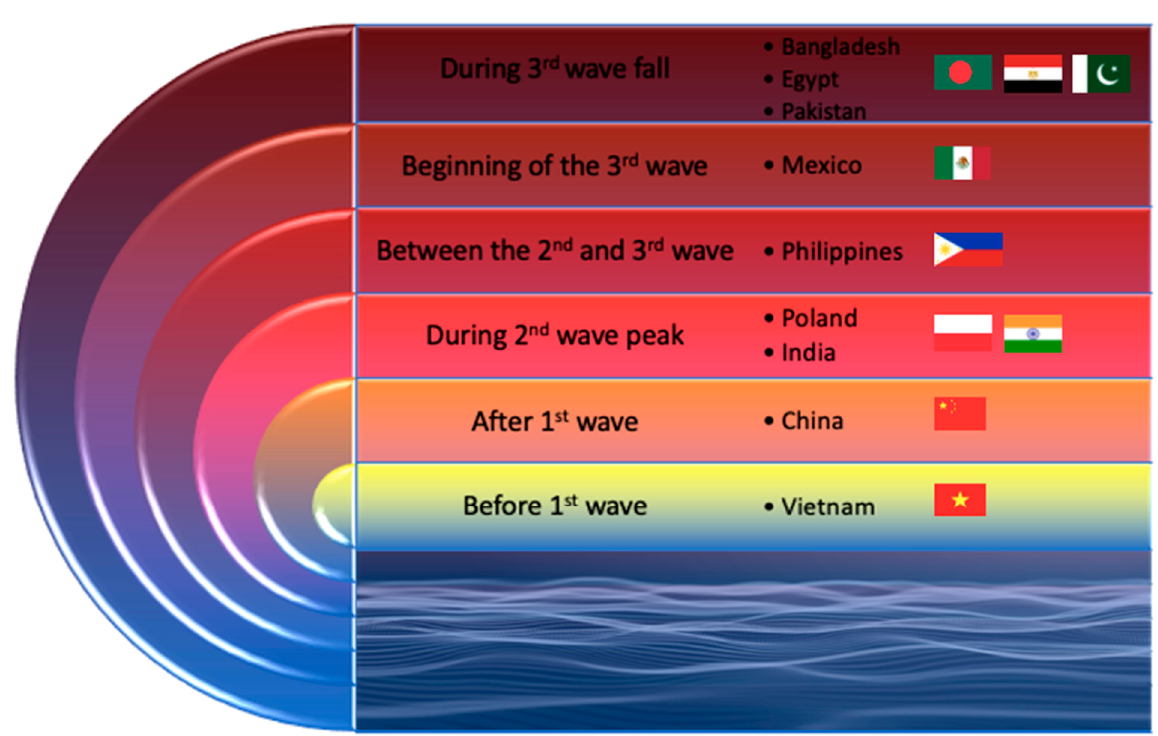
Figure 1. Pandemic point in each country participating in the study. Study start date for individual